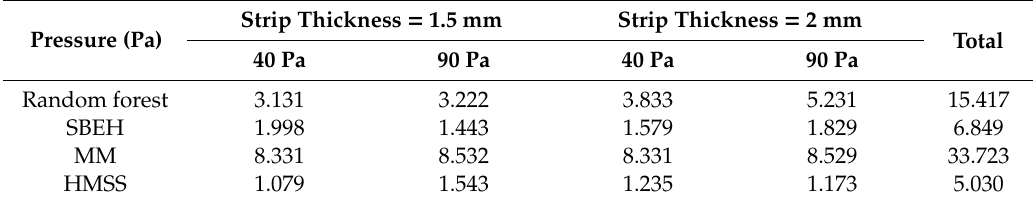
Table 2. Mean absolute error (MAE) value of di ff erent algorithms in the stable state. Pressure